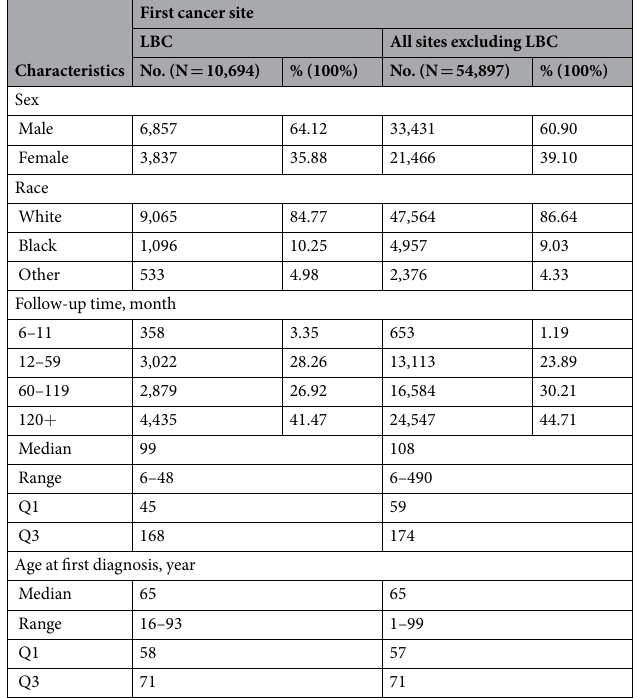
Table 1. Characteristics of patients with SPCs. Abbreviations: SPC, subsequent primary cancer; LBC, lung and bronchus cancer; Q, quartile.